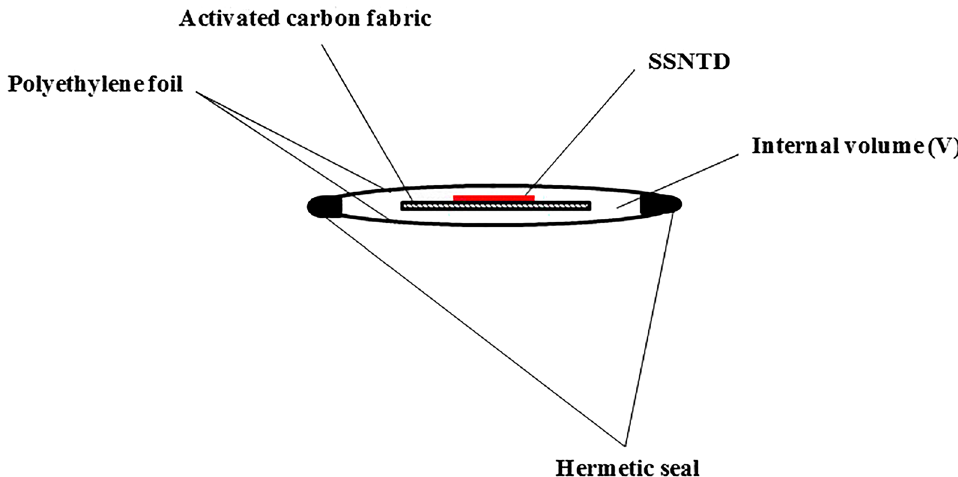
Figure 1. A scheme of the “compensation module” with a detector of activated carbon fabric and SSNTD of Kodak Pathe LR-115/II, used in the present experiments. The module is formed as a polyethylene envelope